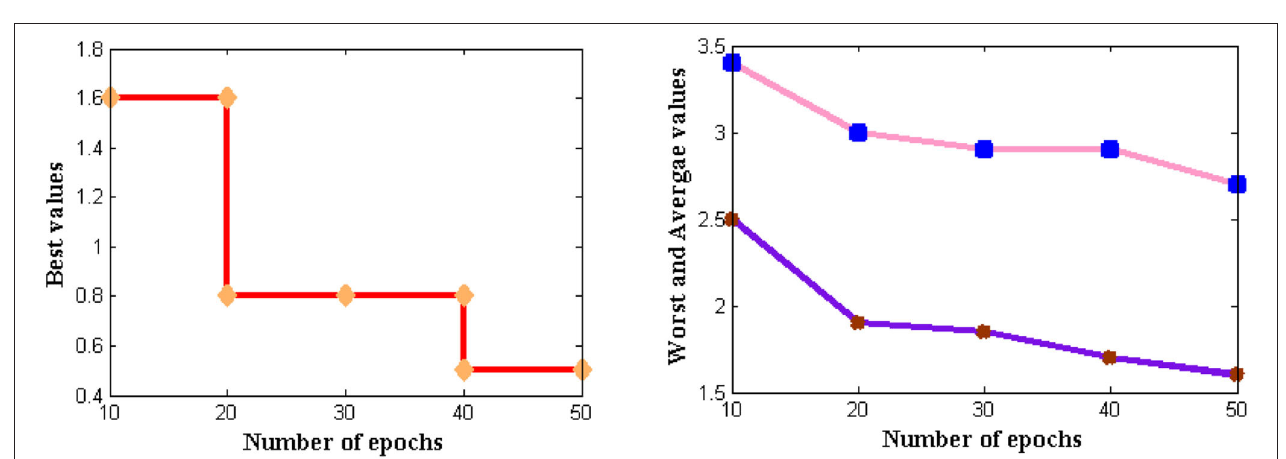
FIGURE 8 | The complexity of time